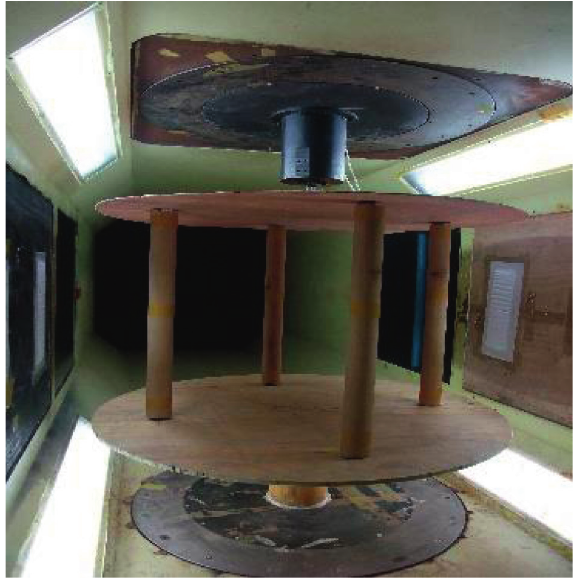
Figure 5: Force-measuring